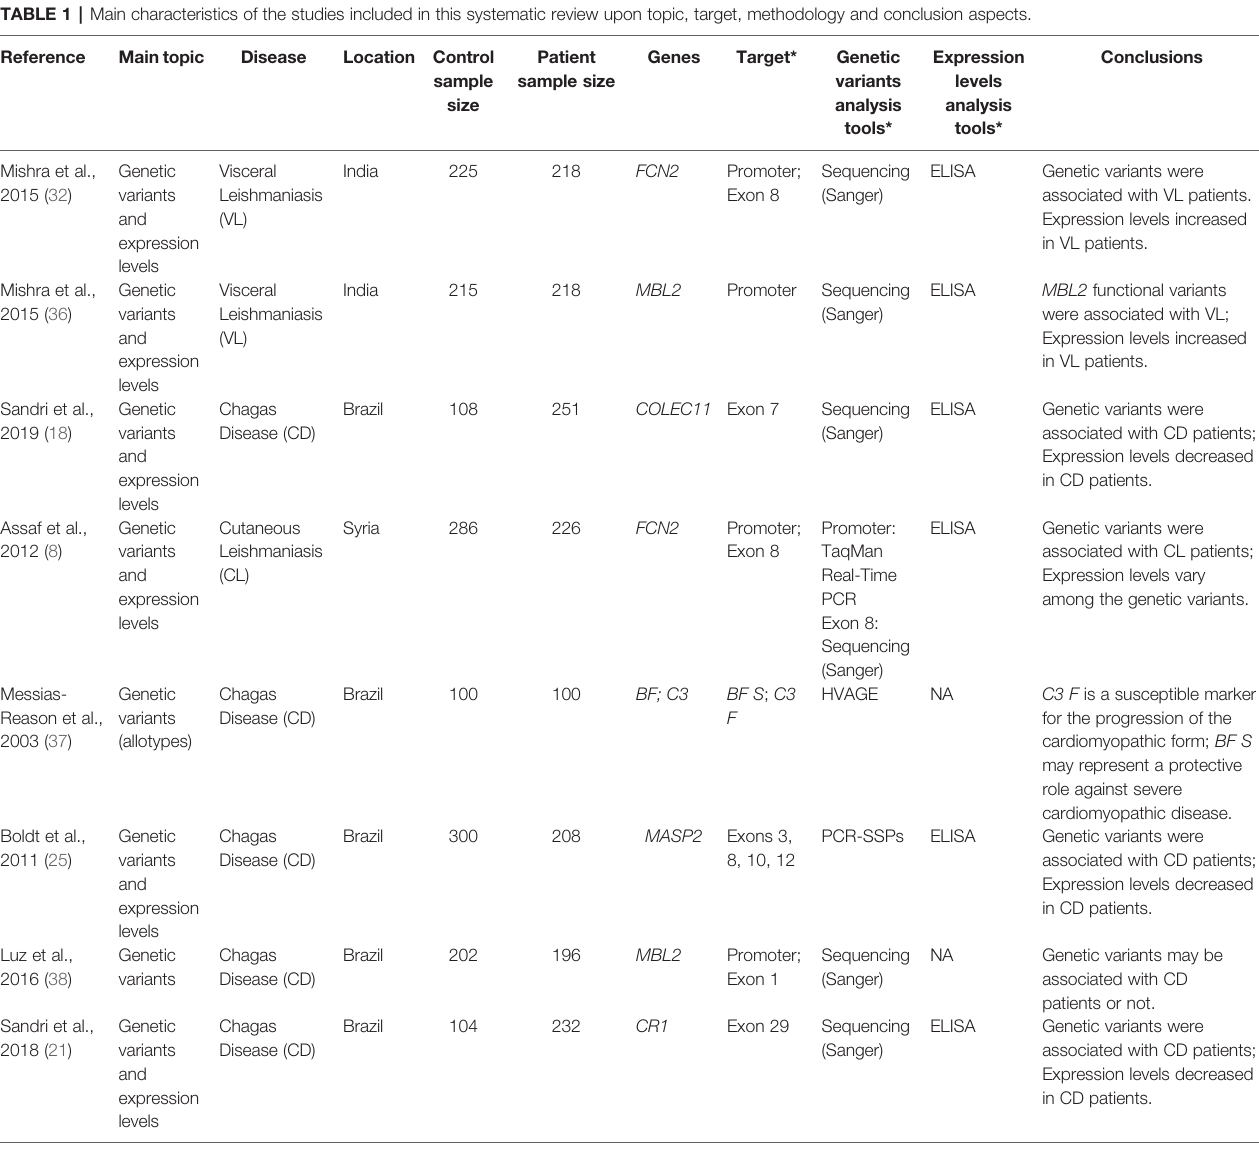
Expression levels decreased in CD